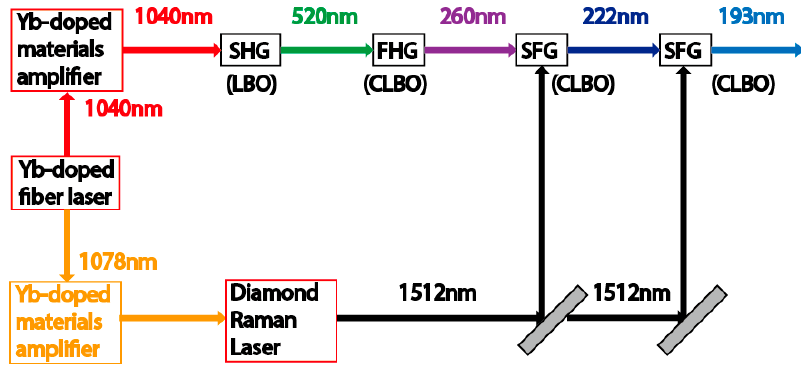
Figure 3. Conceptual setup of the 193 nm laser generation based on the diamond Raman laser.